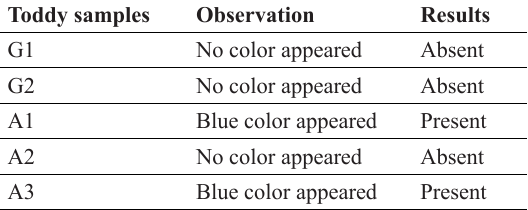
Table 3: Test results for the presence of starch in toddy samples